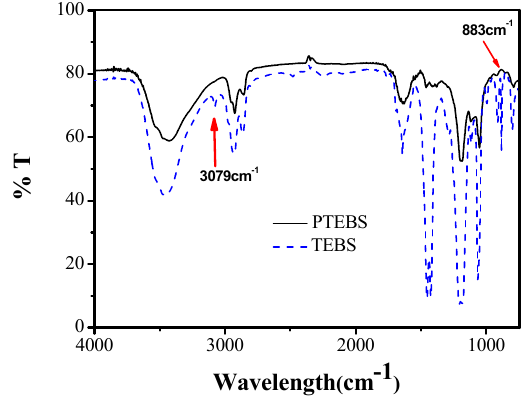
Figure 2. Fourier transform infrared (FTIR) spectra of monomer TEBS and polymer poly[2-(3-thienyl)-ethoxy-4-butylsulfonate] (PTEBS).